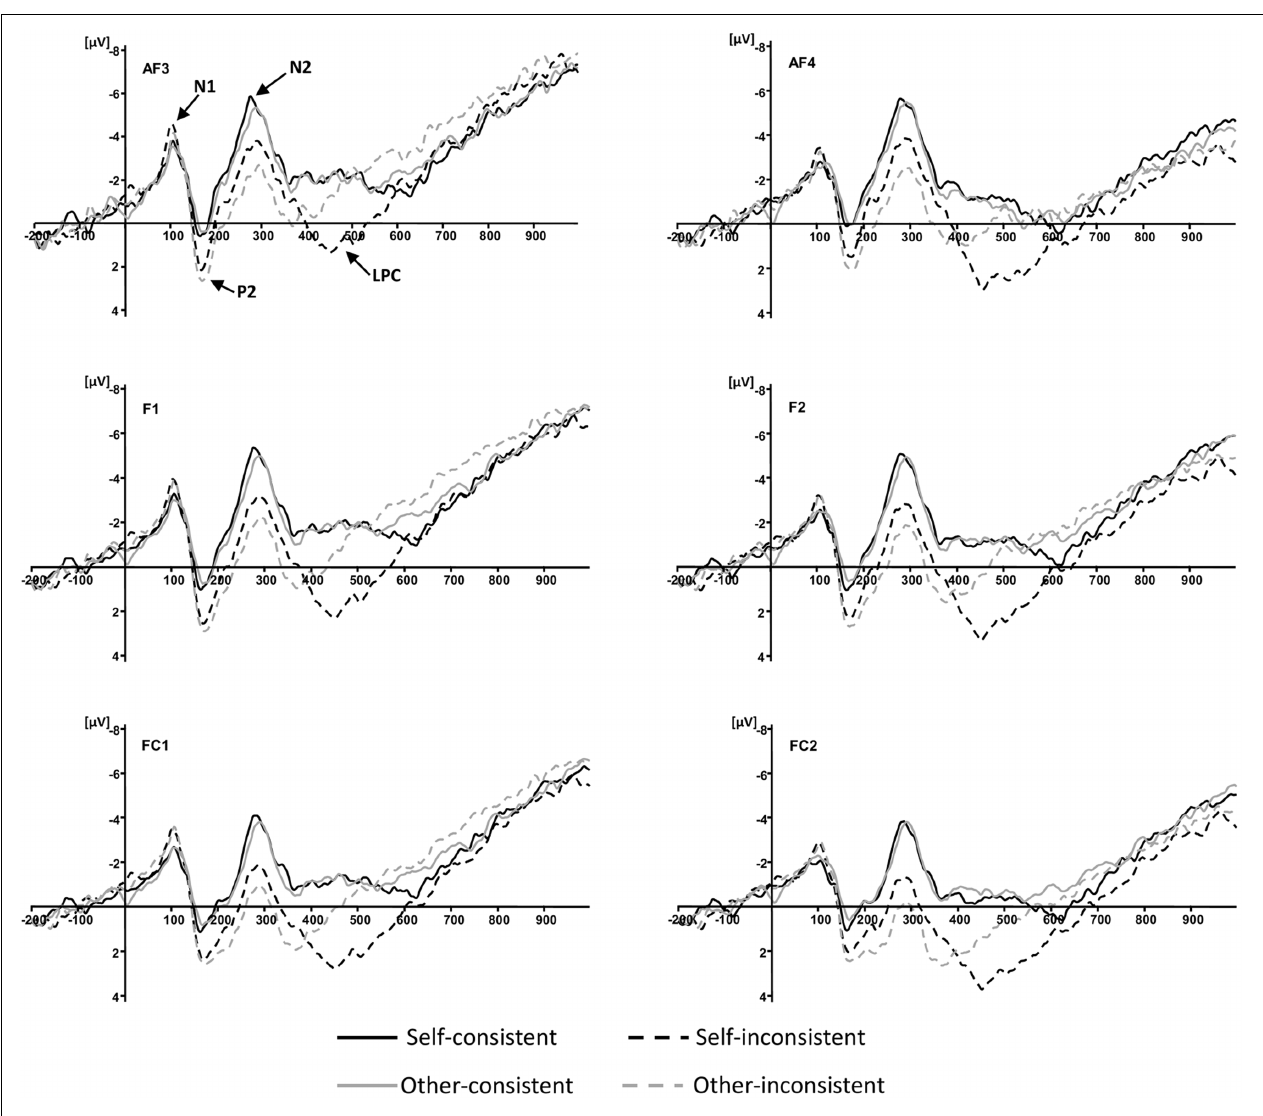
FIGURE 2 | Grand-averaged event-related potential waveforms elicited by four conditions at anterior electrode sites.